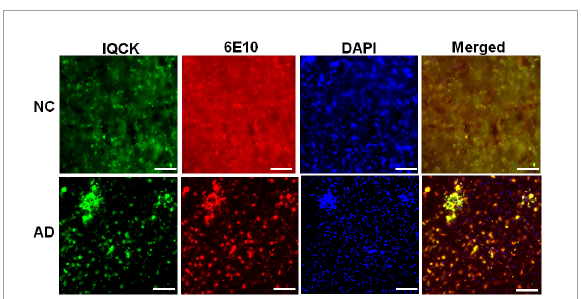
FIGURE7 Immunohistochemical staining of NC and AD brain sections with polyclonal anti-IQCK and monoclonal 6E10 antibodies. Representative micrographs of the brain sections show increased IQCK-immunoreactive neurons (green) and 6E10 antibody-reactive A β and amyloid plaques (red) in the AD brains relative to the NC brain sections. Visualization of yellow color in the merged images indicates colocalization of the IQCK protein with A β and amyloid plaques. Scale bars in all the images represent 100 µ